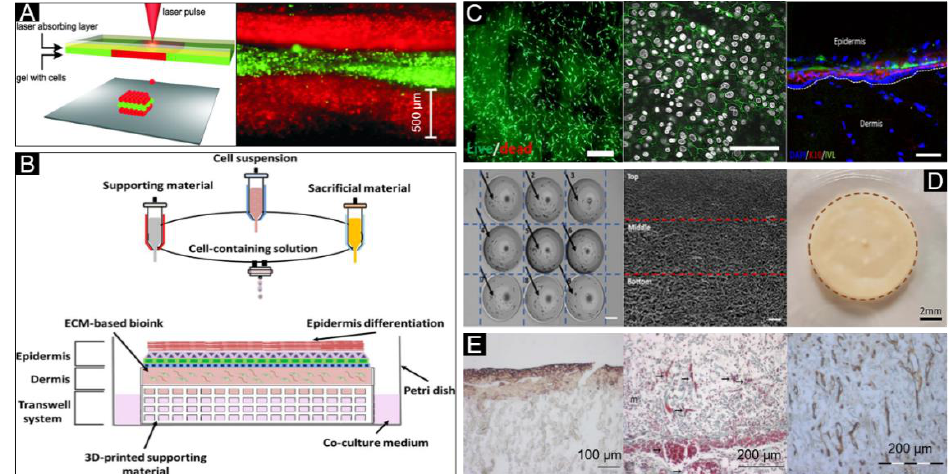
Figure 8. Shear-thinning bioink for skin bioprinting. ( A ) Sketch of the laser printing setup (left) and the alternating color-layers of red (keratinocytes) and green (fibroblasts) (right). Reproduced with permission from [83]; copyright Wiley Periodicals, 2012. ( B ) Extrusion-inkjet printing pattern for fabrication of 3D printed human skin model and its maturation with functional transwell system, all in a single-step process. ( C ) Image and dead images of the contracted compartments at day 7 to reveal their morphology and viability (left, scale bar: 200 μm), immunofluorescence labelling examination of E-cadherin (middle, white: Nuclei, green: E-cadherin, scale bar: 200 μm), and